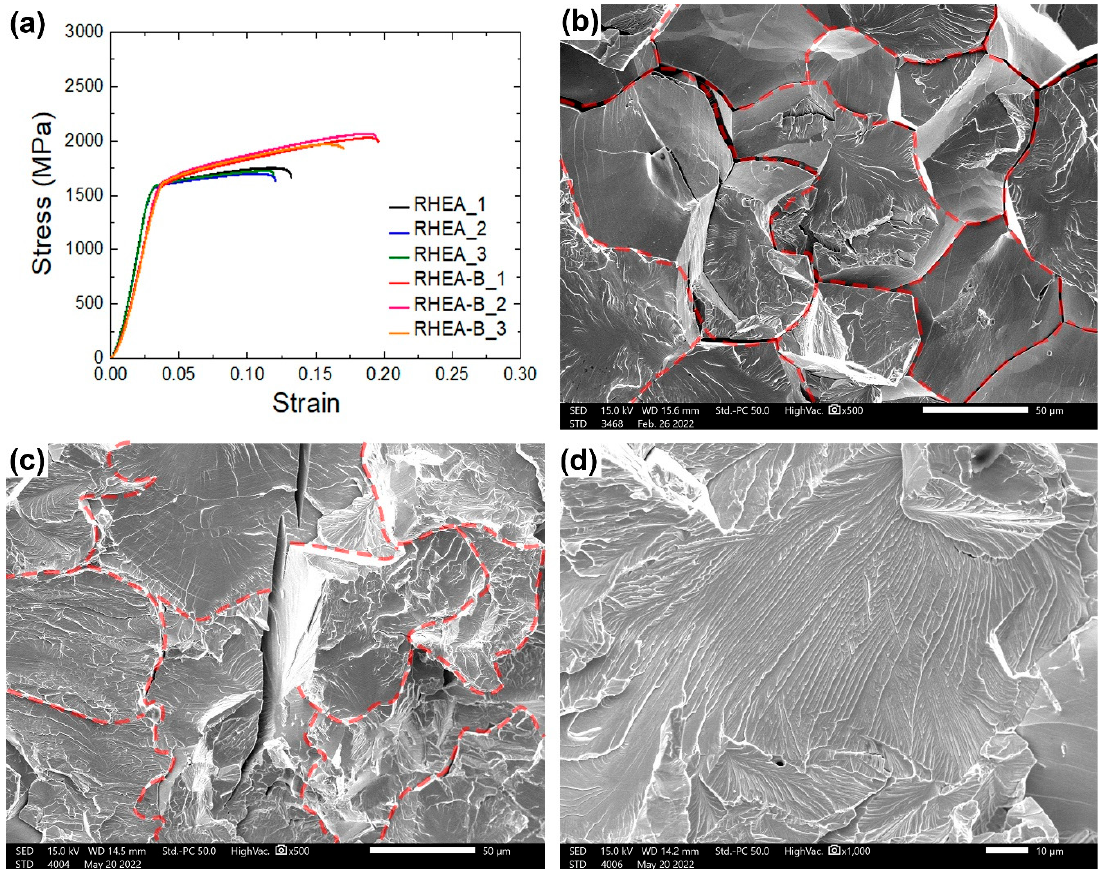
Figure 7. Macro-compression tests of RHEA and RHEA-B samples: ( a ) stress–strain curves, ( b ) SEM fractography of RHEA, ( c , d ) SEM fractographics of RHEA-B (red dashed lines: grain boundaries). Table 4. Macro-Compressive Yield Stresses, Ultimate Strengths, Fracture Stains and Work Hardening Percentages of RHEA and RHEA-B samples.